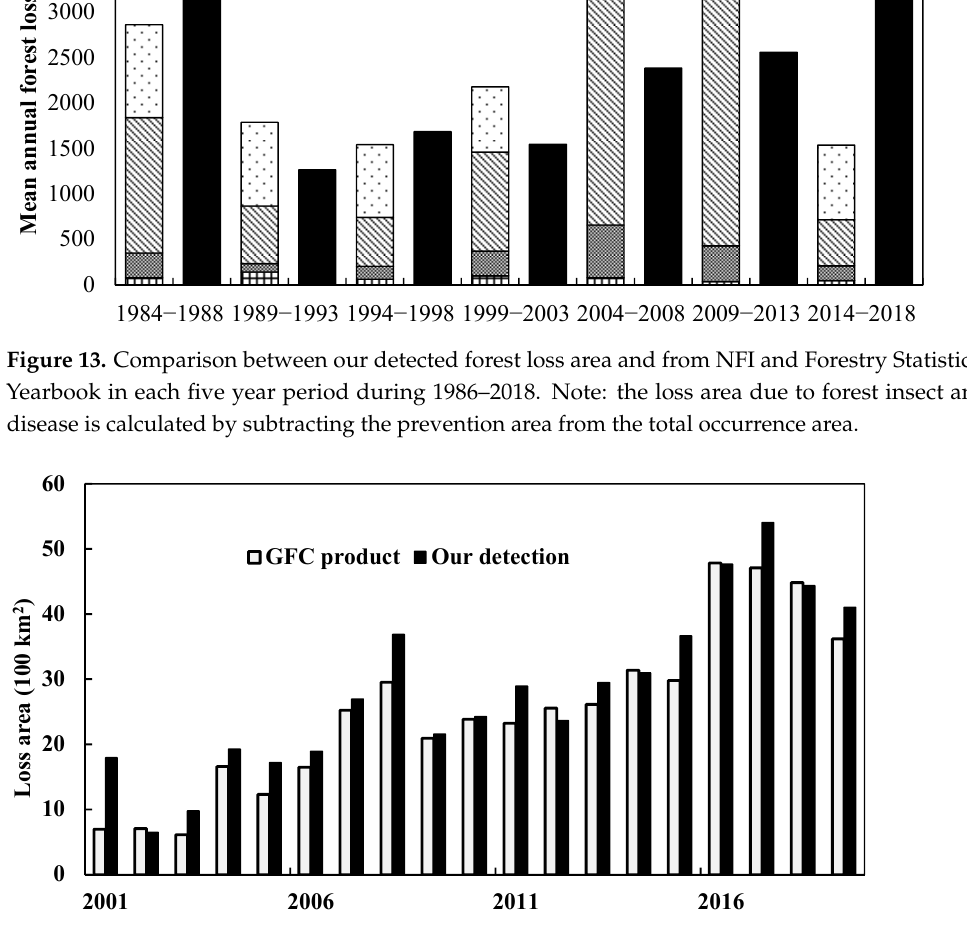
Figure 14. Comparisons of interannual variations in forest loss area (100 km 2 ) between our detection and the GFC product in the study region during 2001 – 2019.